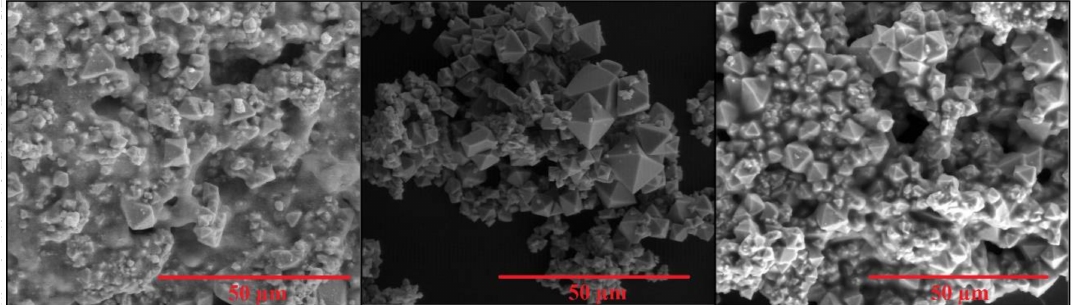
Figure 1. E-SEM micrographs showing the evolution of the morphology of indium oxide materials as a function of the temperature employed during the synthesis. ( Left ), ( middle ), and ( right ) panels correspond to an oxidation step conducted at 400 ◦ C, 500 ◦ C, and 600 ◦ C,